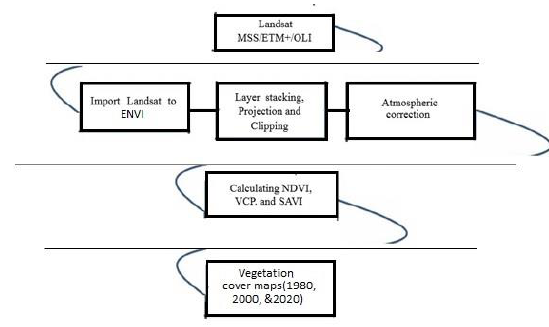
Figure 2: Working Methodology